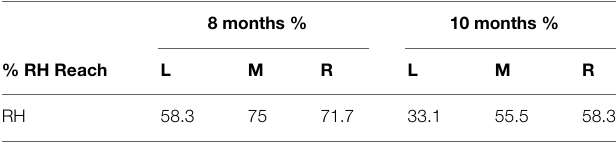
TABLE 1 | Percent (%) of right-handed reaches as a function of age and object starting position.